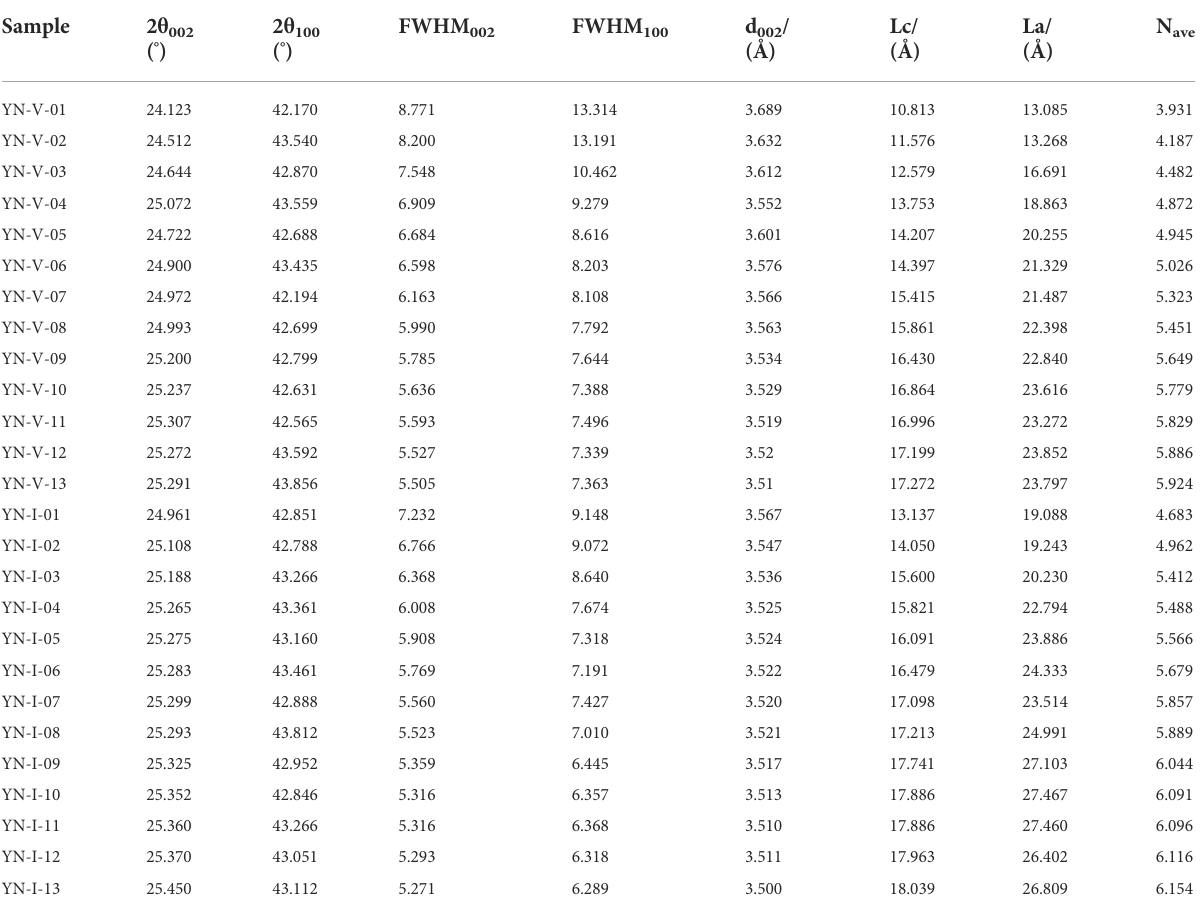
TABLE 5 XRD structure parameters of thermally simulated vitrinite and inertinite samples.